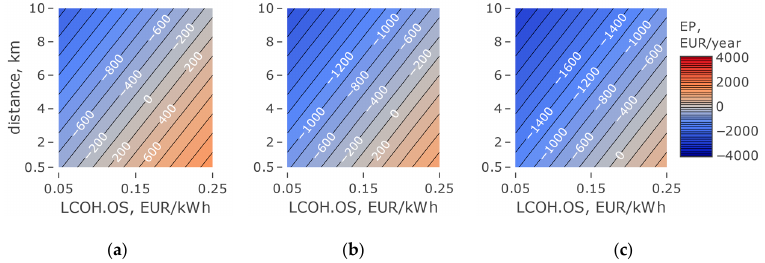
Figure 11. The Yearly Economical Profitable as a function of Levelized Cost of Heating from non-geothermal source (LCOH.OS) and distance between Geothermal Base Station and House, for Total Heat Demand (THD) = 5000 kWh/year and for: ( a ) M-TES price = 2000 EUR; ( b ) M-TES price = 6000 EUR; ( c ) M-TES price = 10,000 EUR.